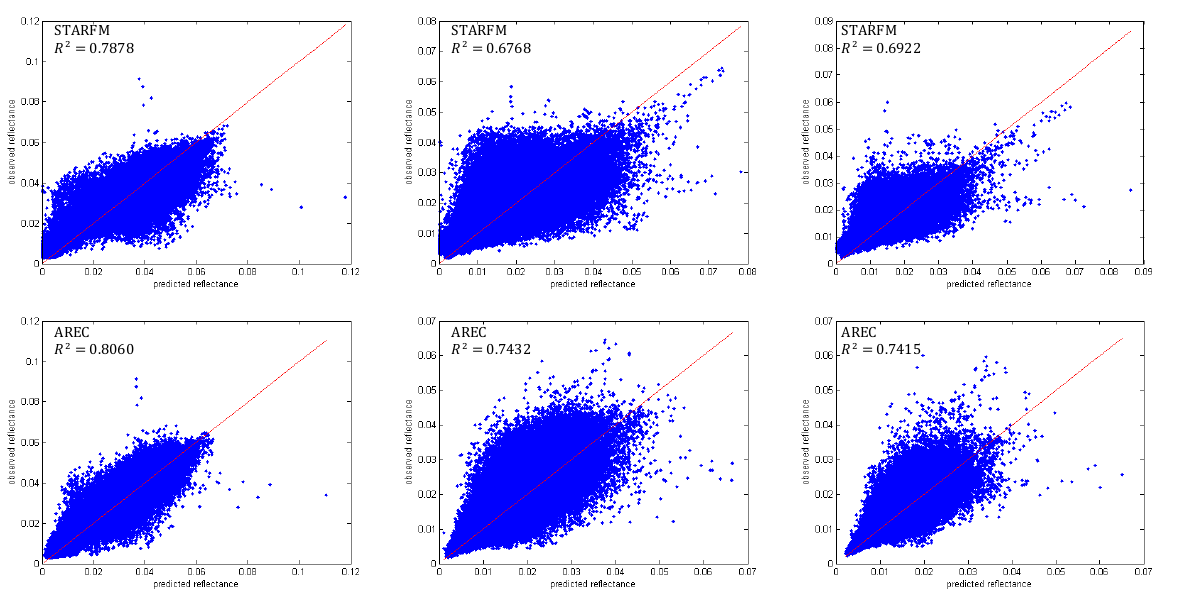
Figure 3. Scatter plots of the predicted reflectance and the real one product by STARFM and AREC for NIR, Red and Green band in Shenzhen data set